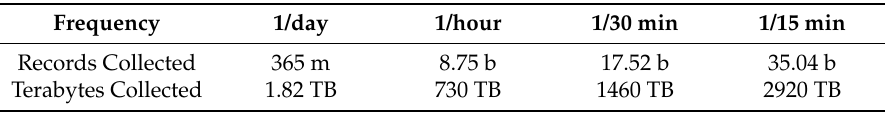
Table 1. Smart Meter Data Collection for One